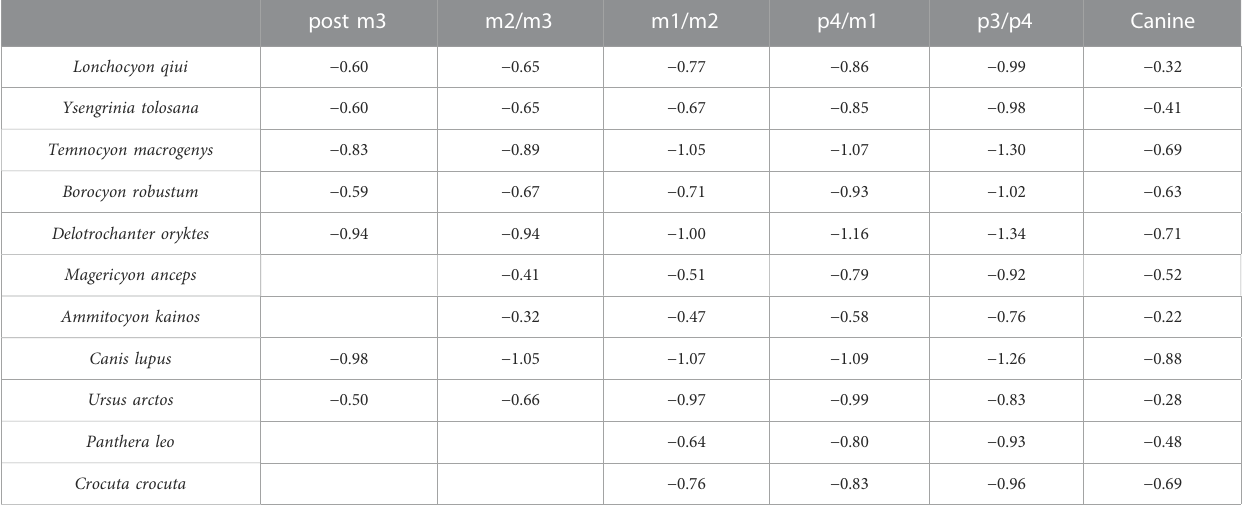
TABLE 4 Labiolingual mandibular force (logZy/L) values of L. qiui and compared carnivorans along the